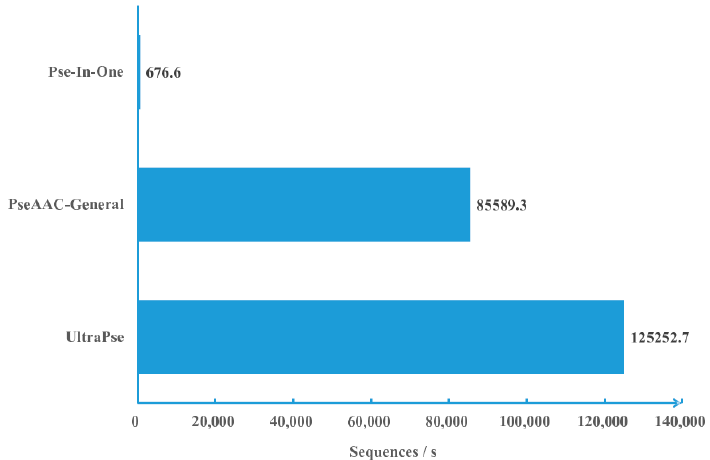
Figure 1. Computational efficiency comparisons. Three programs are compared. The comparison was carried out by letting the three programs compute amino acid compositions on the same dataset on the same machine. Every program was executed with the same parameters for three times. The average execution time was applied in calculating the computational efficiency. The computational efficiency is measured by the average number of sequences that are processed every second. Pse-In-One: A